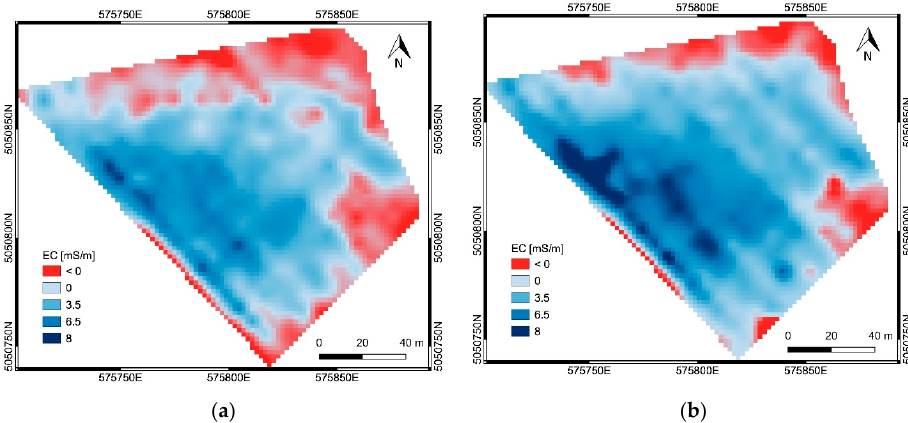
Figure 5. The obtained EC maps (mS/m): ( a ) frequency 15 kHz, corresponding to a DoE of 1.5 m; ( b ) frequency 10 kHz, corresponding to a DoE of 2.5 m. Red color area (area ‘b’) corresponds to gravelly soils (EMI measurement not valid).